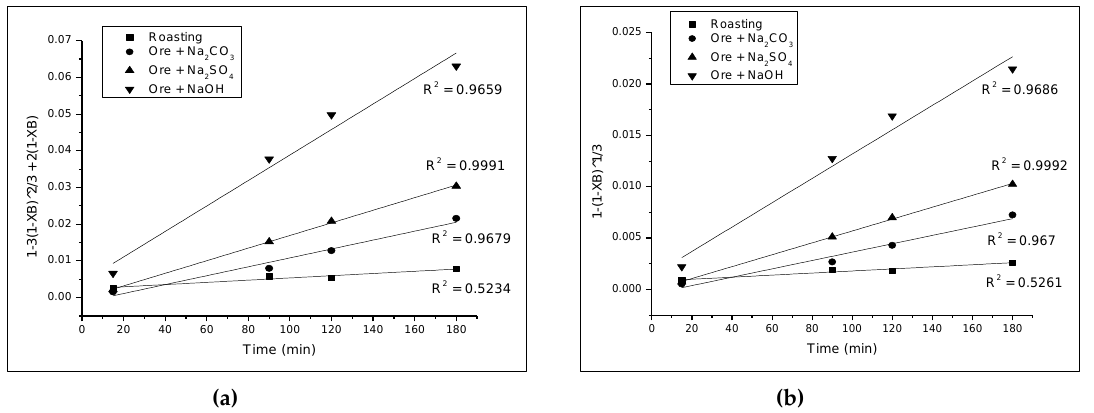
Figure 8. A linear fit of the nickel leaching kinetics at pH 1 and a temperature of 80 ◦ C for ( a ) interface chemical reaction and ( b ) diffusion of reactants or products.